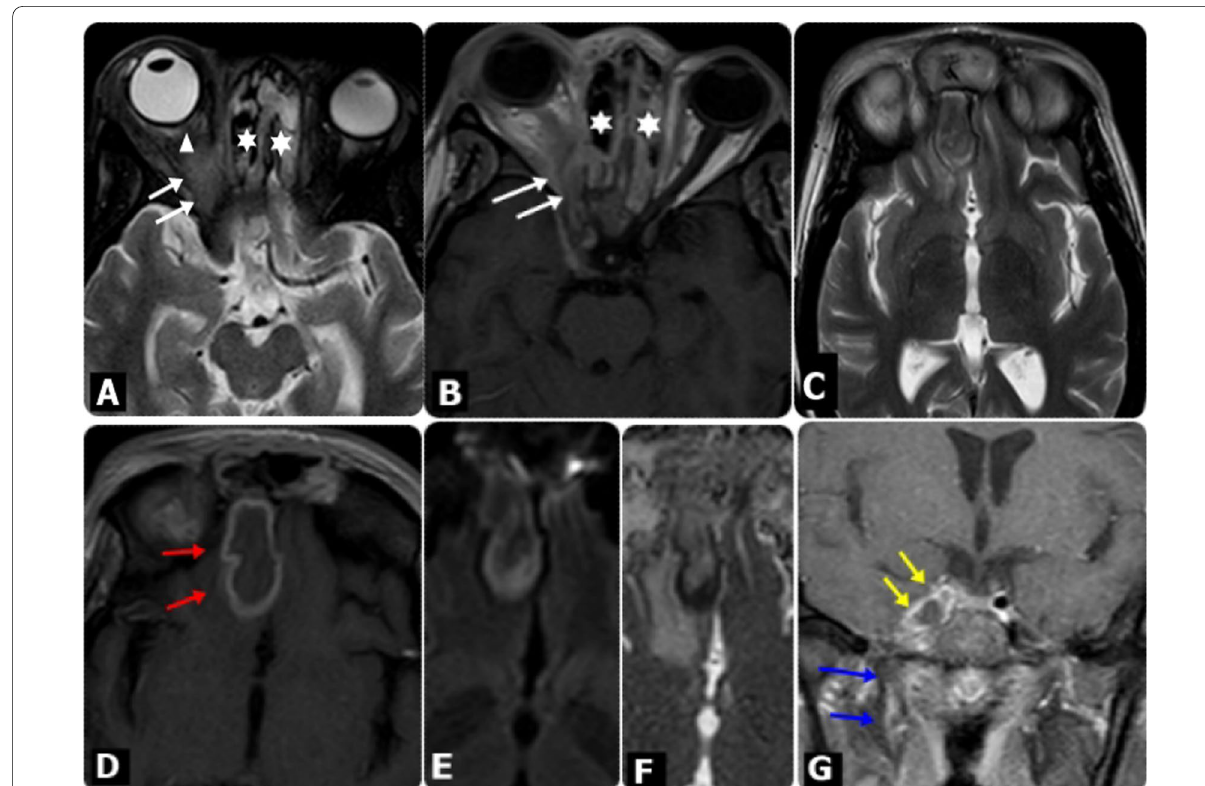
( D ), presenting restricted diffusion on DW images at b‑value 1000 ( E ) and apparent diffusion coefficient (ADC) map ( F ) in keeping with cerebral abscess. G Coronal post‑contrast fat‑saturated T1WI showing mild enlarged right cavernous sinus with patchy heterogeneous enhancement, with attenuated cavernous portion of the Rt. ICA (yellow arrows), associated with inflammatory spread to the Rt. infra‑temporal fossa region (blue